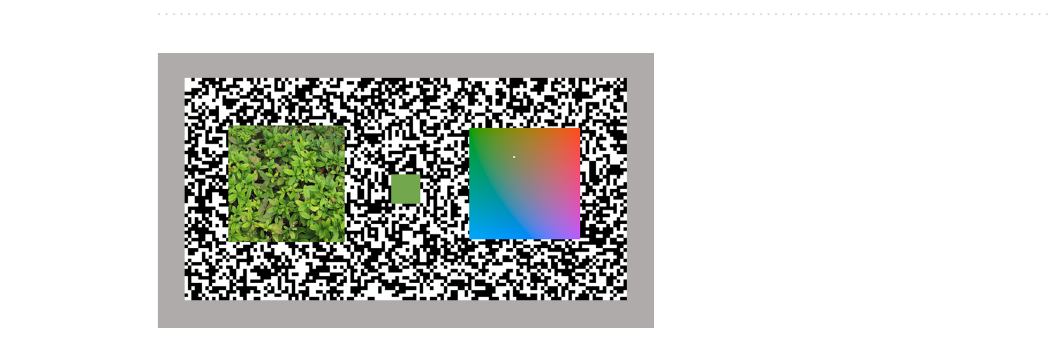
Figure 1. Examples of natural surface images used in Experiment 1.